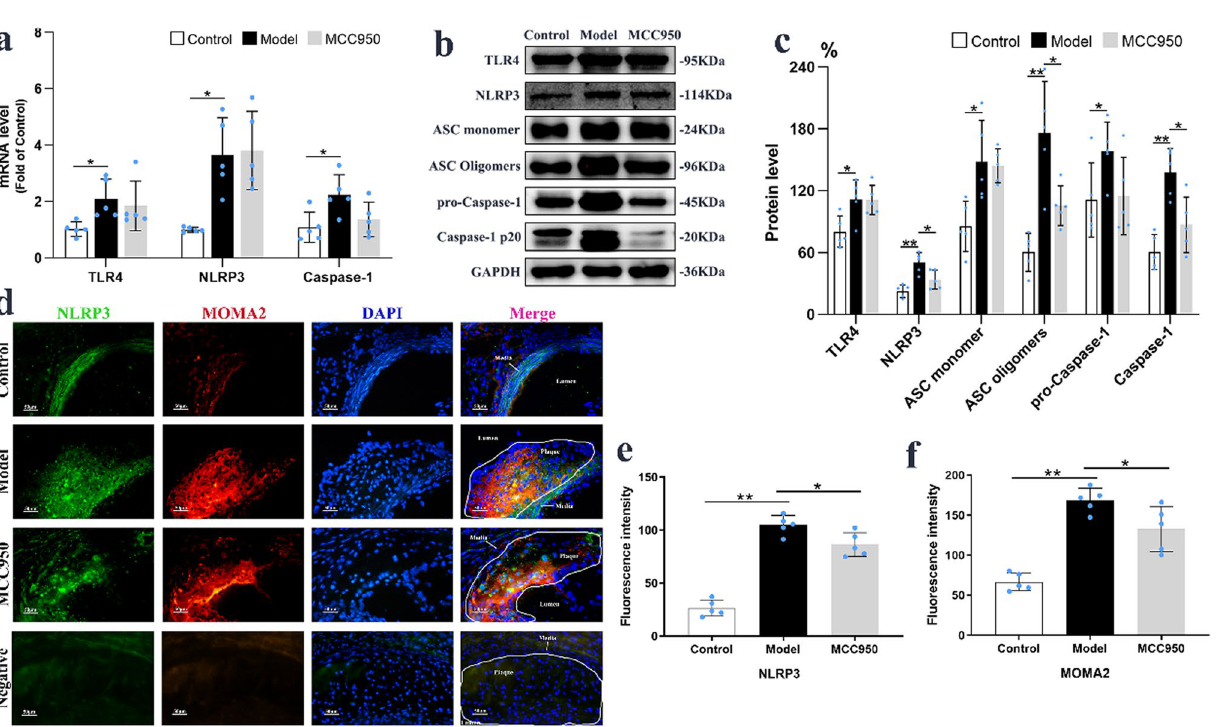
Figure 3. MCC950 inhibited NLRP3 inflammasome activation of macrophages in the aorta. The mRNA levels of TLR4, NLRP3 and Caspase-1 in aorta (n = 5/group) were shown on ( a ), while the protein levels of TLR4, NLRP3, ASC monomer, ASC oligomers, pro-Caspase-1 and Caspase-1 (n = 5/group) were exhibited on ( b , c ). The fluorescence stained images and quantitative analysis of NLRP3 (green), MOMA2 (red) in aortic root of mice (n = 5/group) were displayed on ( d – f ). GAPDH served as an internal control. The magnification was ×400, Scale bar = 50 μm. Data were presented as mean ± SD. * P < 0.05 was considered significant, ** P <